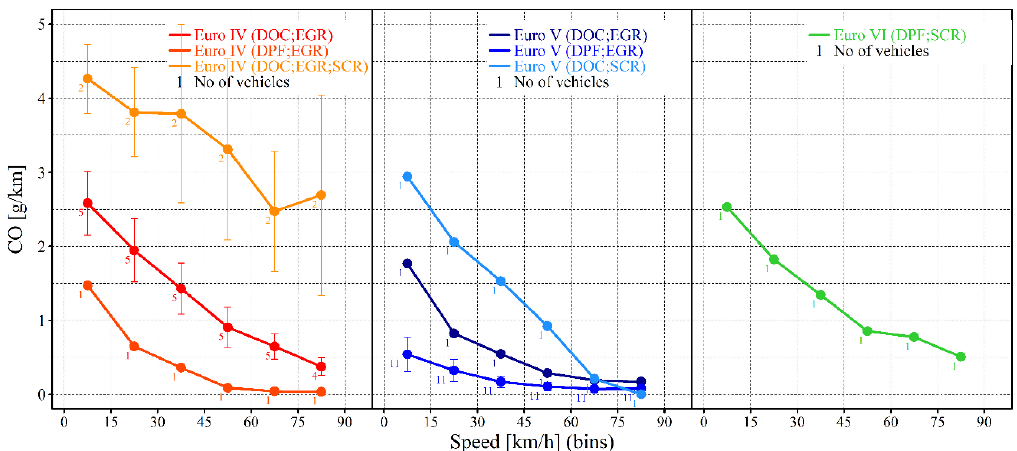
Figure A3. Sample mean and ± one standard error limits of the distance-based CO emission levels over speed (500m driving sequences).